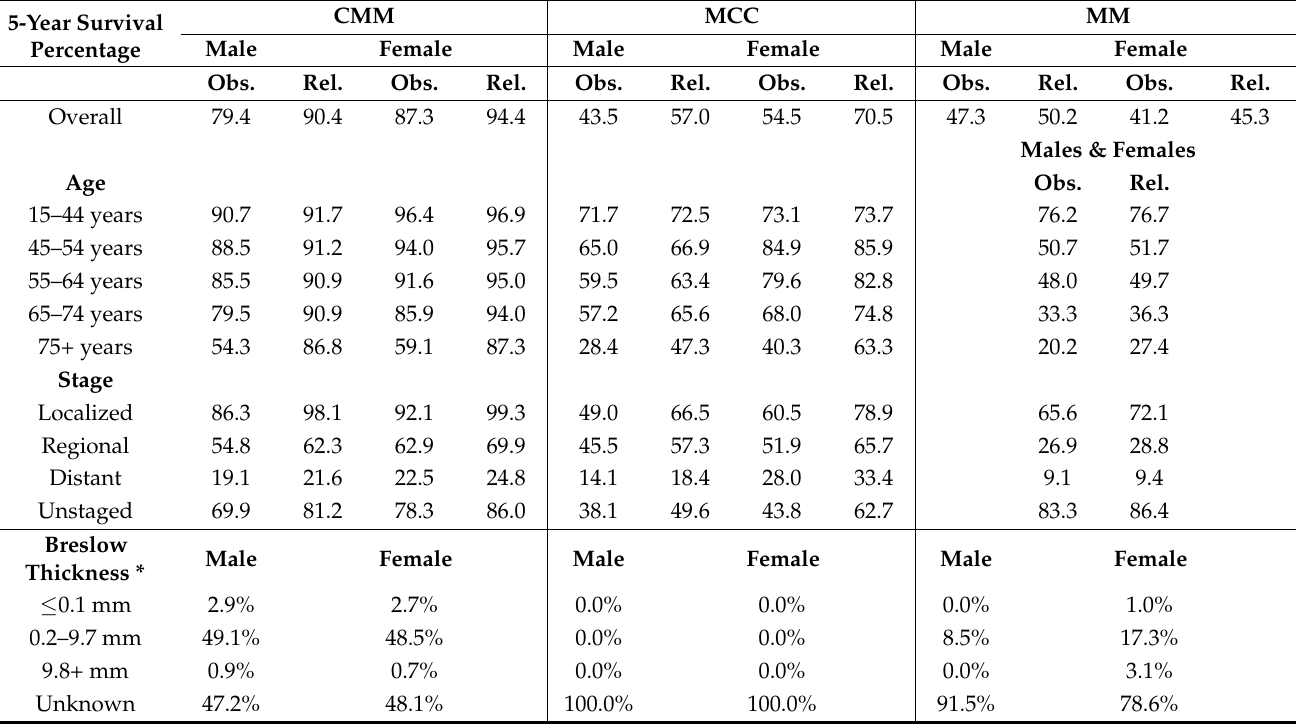
Table 4. Five-year survival and Breslow thickness of cutaneous malignant melanoma (CMM), Merkel